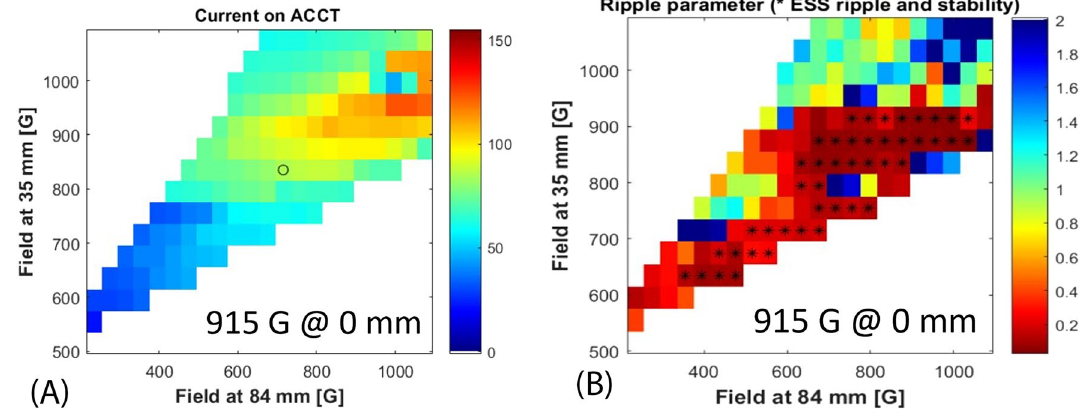
Figure 9. ( A ) ACCT current measured around the HSMDIS configurations (marked with a circle); ( B ) Ripple parameter map and ESS compliant configurations (marked with an asterisk).